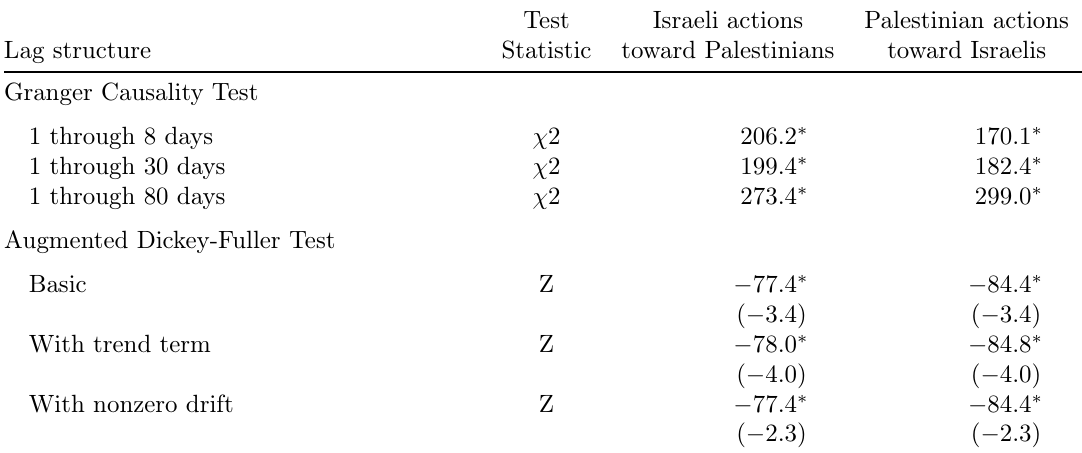
Test Israeli actions